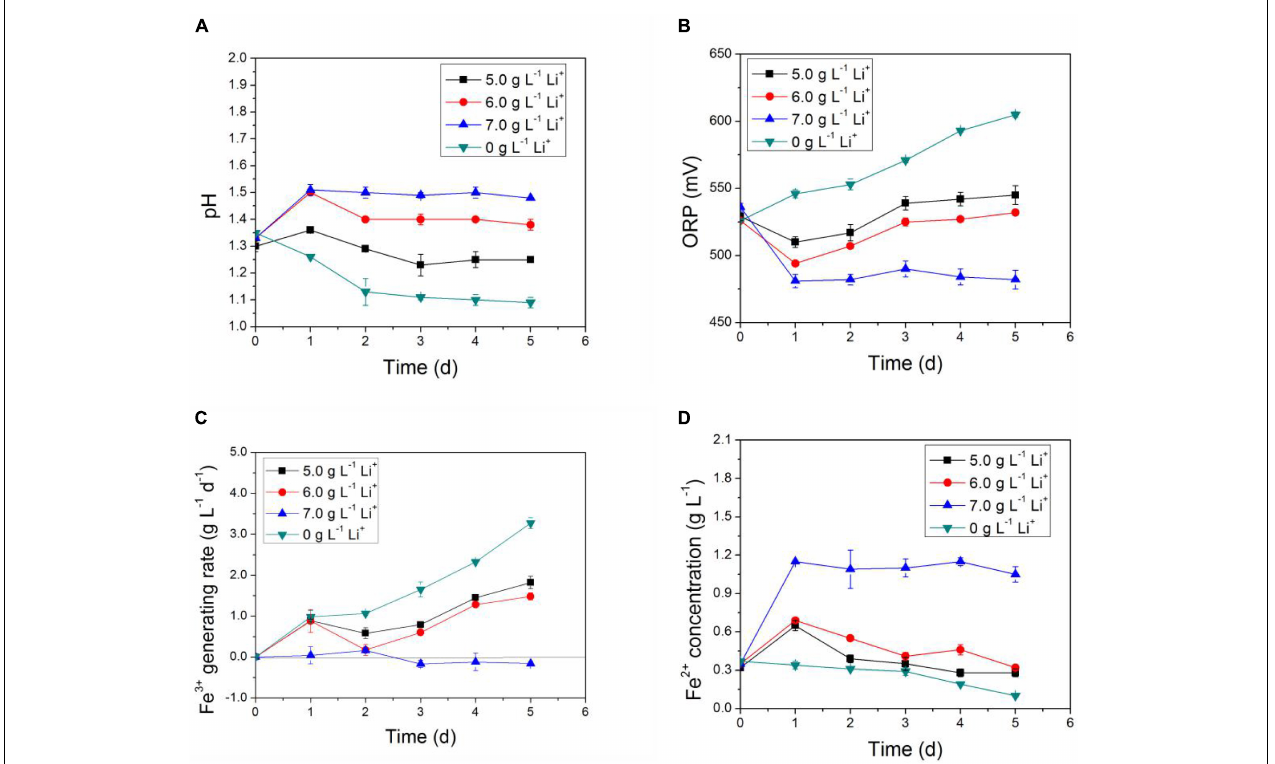
FIGURE 3 | Time-courses for (A) pH, (B) ORP, (C) Fe 3 + generation rate, and (D) Fe 2 + concentration under simulated bioleaching system of different Li +